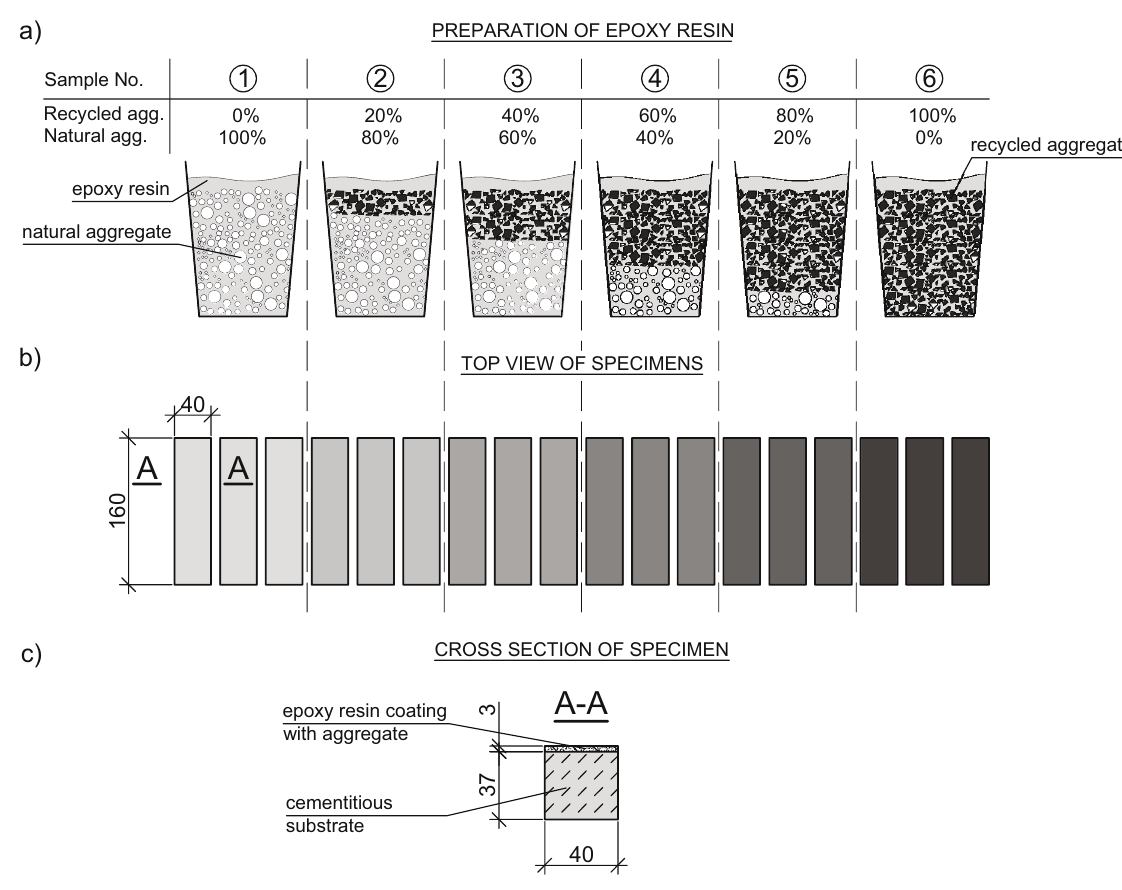
Figure 3: Scheme of the preparation process of the samples: ( a ) epoxy resin with di ff erent amounts of recycled and natural aggregate; ( b ) top view of the specimens after the application of epoxy resin on the concrete substrate – a darker color of the sample means a higher amount of recycled aggregate in the epoxy resin; ( c ) cross section of the prepared